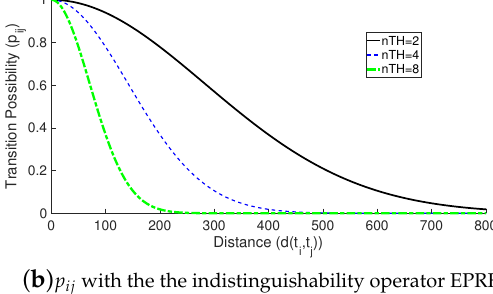
Figure 2. Transition possibility p ij with nTH = 2,4,8 and power value n = 2. Whichever possibility response function is used, (11) or (12), the possibilistic transition matrix for each robot, M , must be transformed into a probabilistic matrix for the possibilistic and